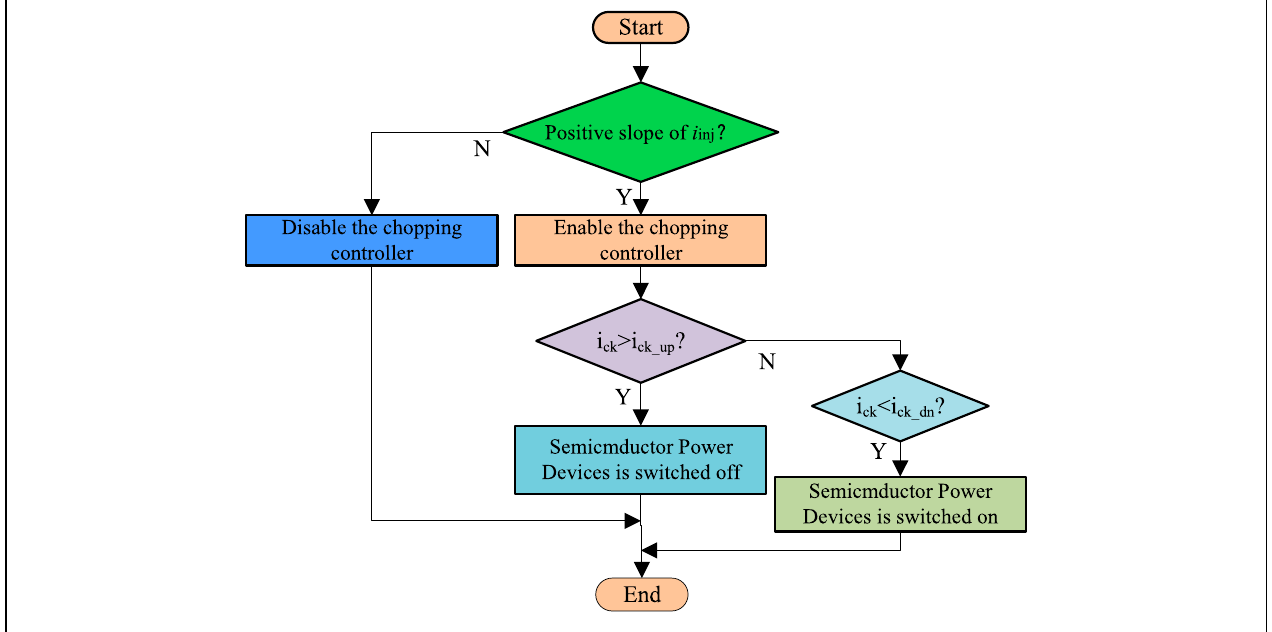
FIGURE 5 | Control flow chart of the synchronous current chopping method.